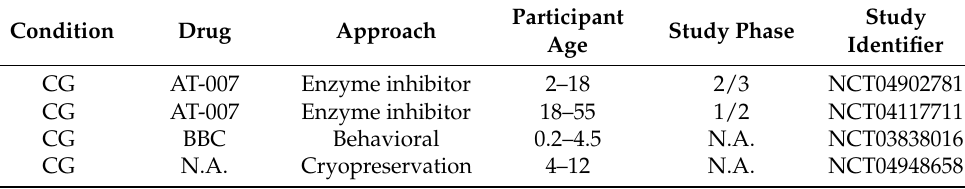
Table 2. Ongoing interventional clinical trials for novel treatments in galactosemias.